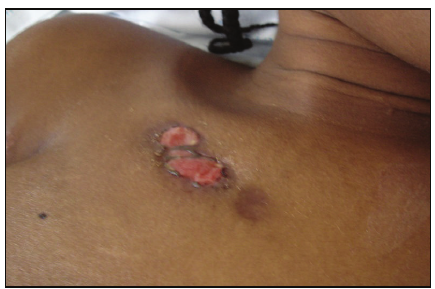
Figure 1: Clinical manifestation of cutaneous tuberculosis involving the right infraclavicular region and showing three lesions, one nodular and the others ulcerated.